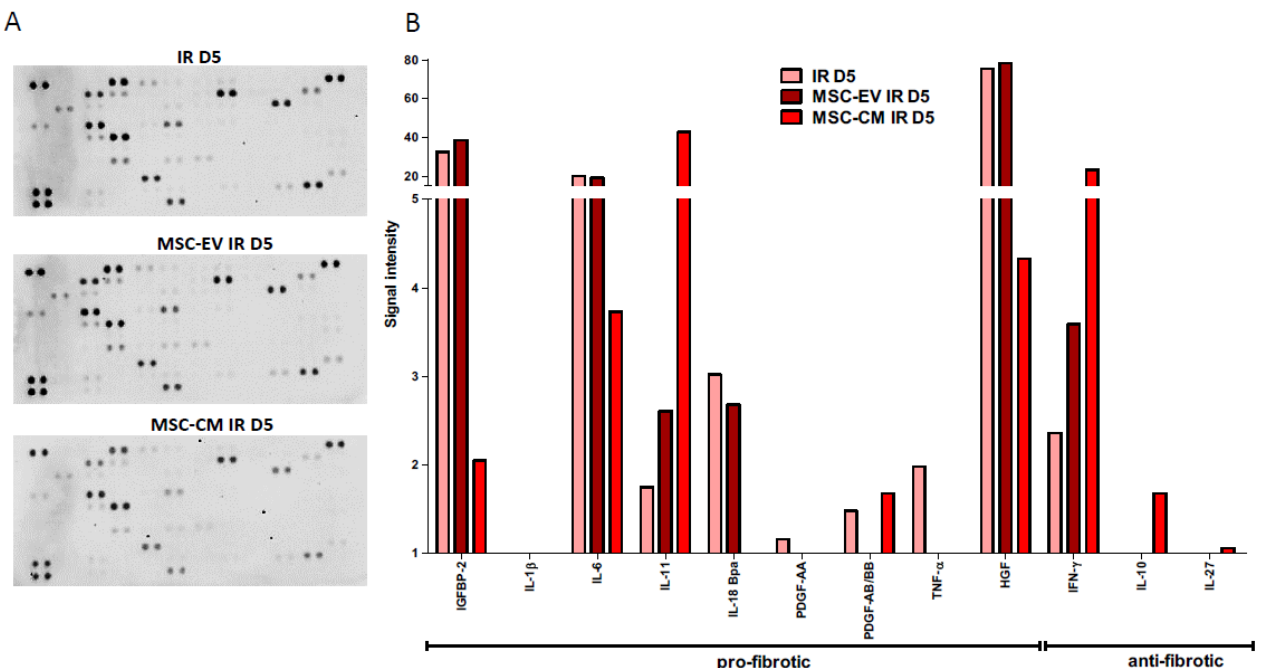
Figure 8. Profiling of cytokines expressed by secretomes of irradiated untreated fibroblast or preconditioned with MSC-EV or MSC-CM obtained with Proteome Profiler Human XL cytokine Array Kit (R&D). ( A ) Representative image of dot blot; ( B ) graph showing signal density of dot blot of each protein normalized to positive spot pixels.